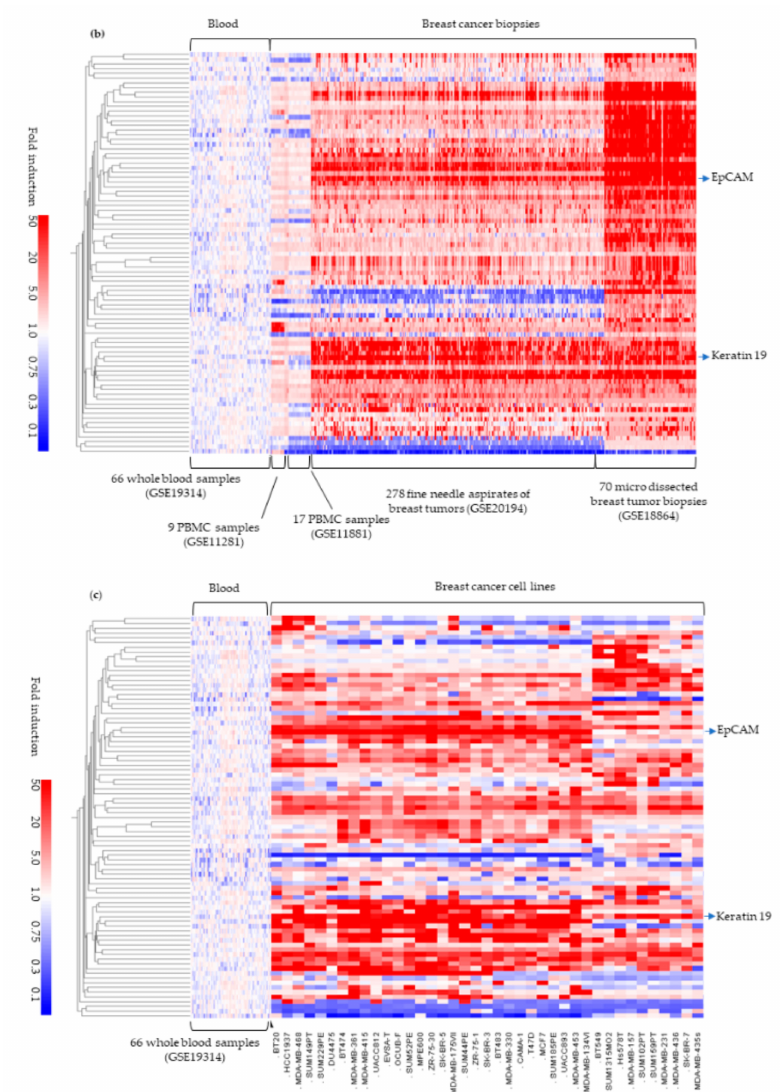
Figure 1. Scheme for the discovery of 80 genes and evaluation of expression in di ff erent datasets. ( a ) Scheme of selection for the discovery of the 80 genes. Three-dimensional (3D) culture assays allow phenotypic discrimination between nonmalignant and malignant mammary cells. Nonmalignant cells form polarized and acinus colonies attached to growth, while malignant cells form disorganized, proliferative and nonpolar colonies. ( b ) Heatmap showing the expression profile of the 80 genes in 348 breast cancer biopsies when normalized to non-breast cancer blood samples, including two datasets from peripheral blood mononuclear cells. ( c ) Heatmap showing the expression levels of the 80 genes in 39 breast cell lines when normalized to non-cancer blood samples. PBMC: peripheral blood mononuclear cell, CTC: circulating tumor